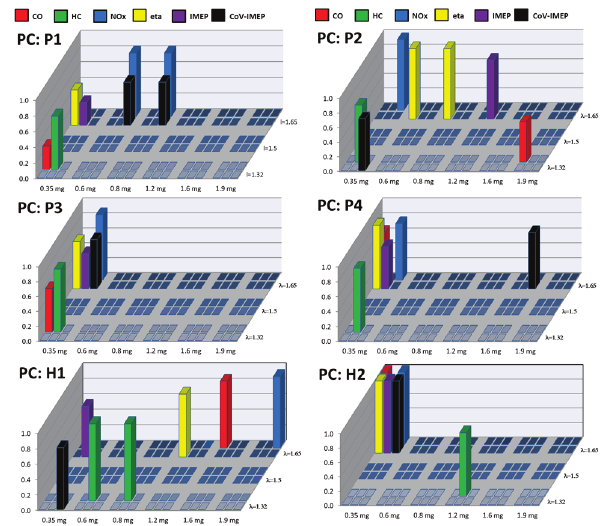
Fig. 20. Selection of the best combustion system configuration for dif- ferent impact factors assigned to different coefficients (2 nd approach)